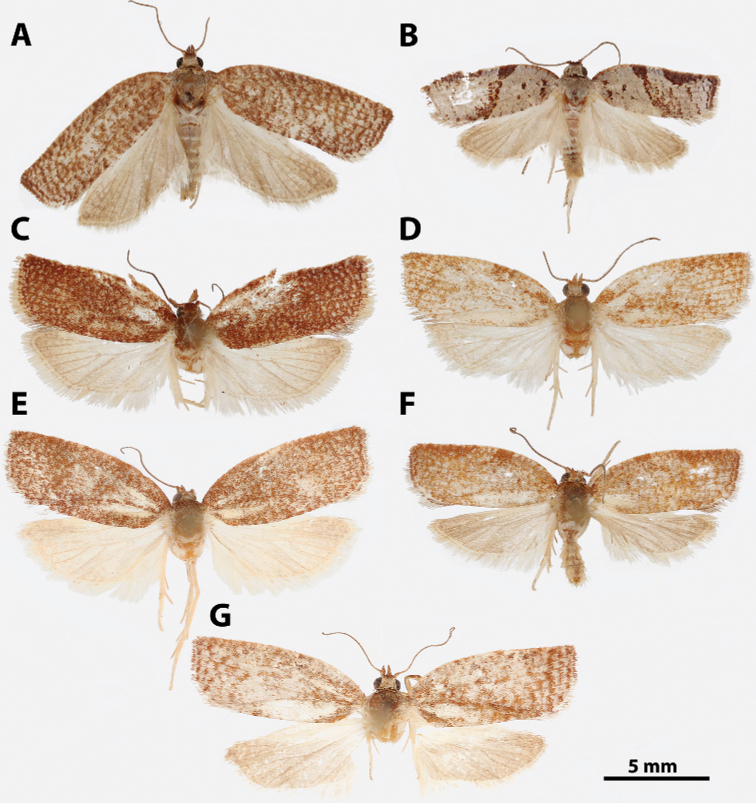
Claduncaria
ochrochlaena group adults. ACla.
maestrana ♀, Cuba (VBC) BCla.
maestrana♂, Cuba (VBC) CCla.
ochrochlaena ♀, Dominican Republic (CMNH) DCla.
ochrochlaena holotype ♂, Dominican Republic (CMNH) ECla.
rawlinsana sp. nov. paratype ♀, Dominican Republic (CMNH) FCla.
rawlinsana sp. nov. holotype ♂, Dominican Republic (CMNH) GCla.
praedictana sp. nov. holotype ♀, Dominican Republic (CMNH).